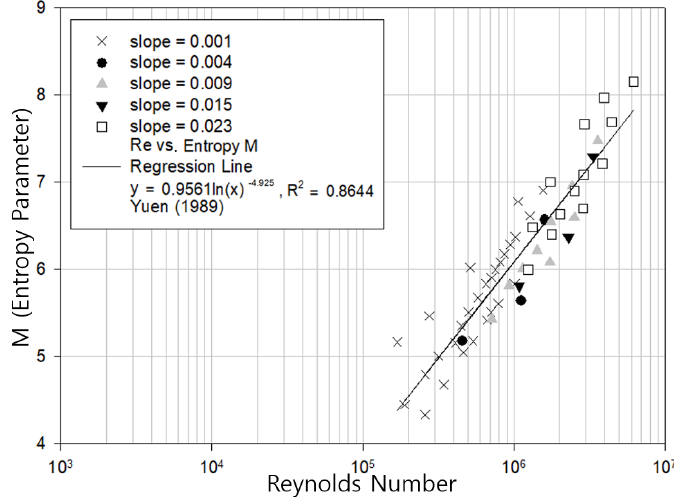
Figure 3. Relationship between (cid:1839) and (cid:1844)(cid:1857) calculated using Yuen’s data.